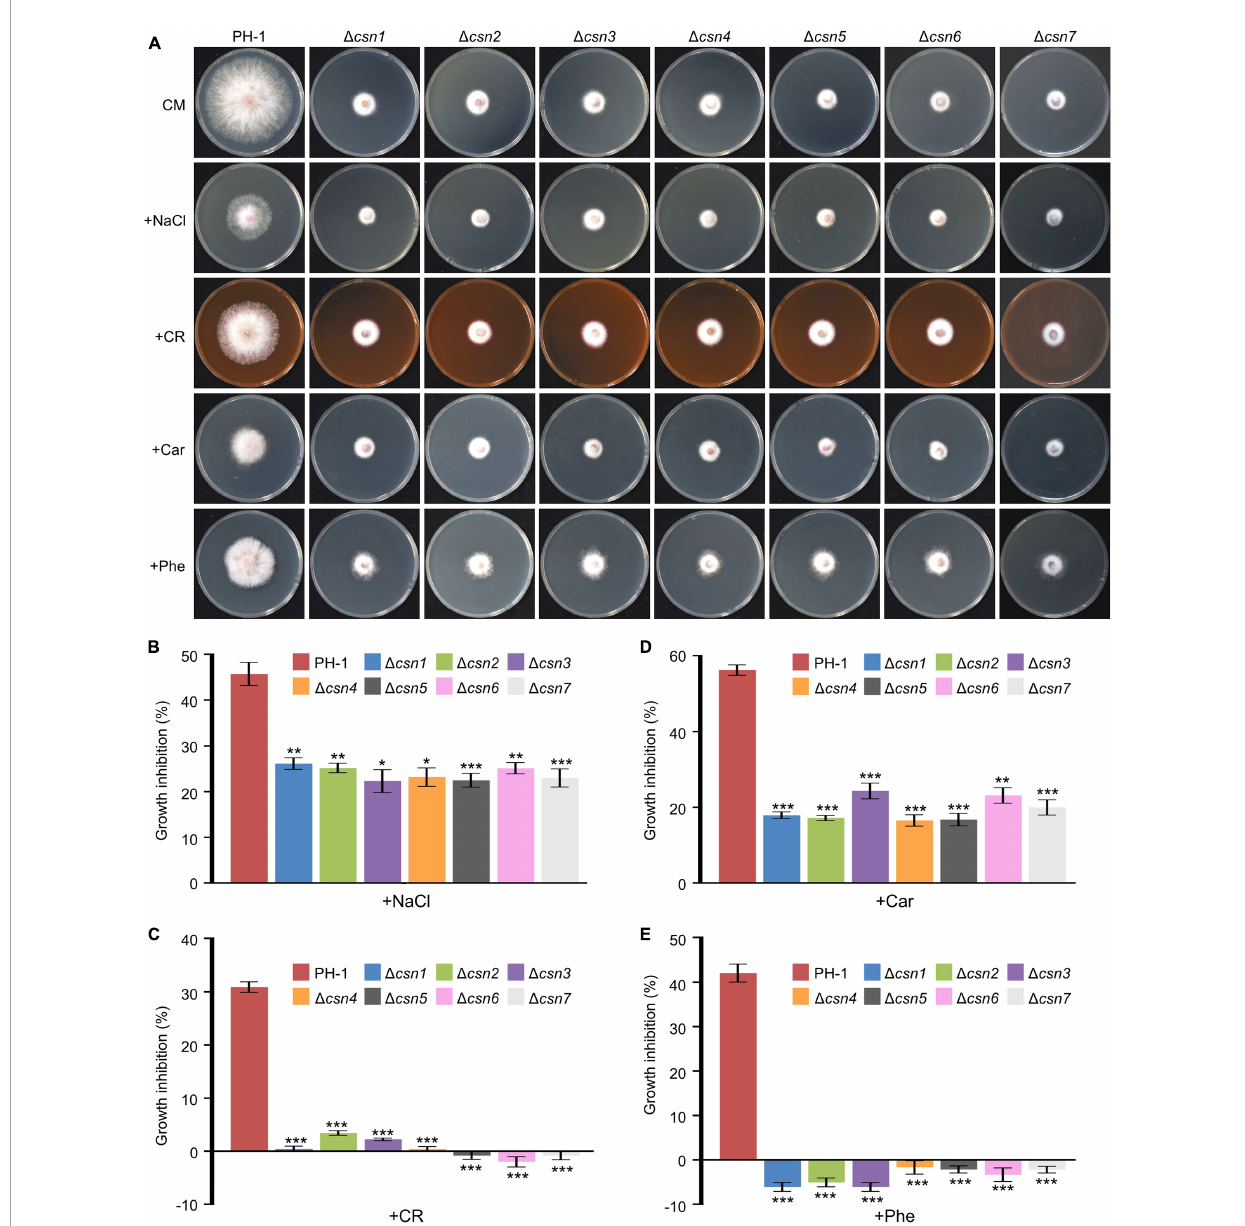
FIGURE5 Control of stress responses by the Csn complex. (A) Morphologies of the indicated strains after incubation on complete medium (CM) supplemented with multiple abiotic stresses including NaCl, congo red (CR), carbendazim (Car), and phenamacril (Phe). (B) The inhibition of the mycelial growth rate was examined after each strain was incubated for 3 days on complete medium supplemented with 1 M NaCl (B) , 0.4 g/L congo red (C) , 0.5 µ g/mL carbendazim (D) and 0.25 µ g/mL phenamacril (E) . The error bars indicate the standard deviation from three independent experiments. Statistical analysis was performed using Student’s t -test. The single asterisk indicates statistical significance with p < 0.05, the double asterisks indicate statistical significance with p < 0.01 and the triple asterisk indicates statistical significance with p <